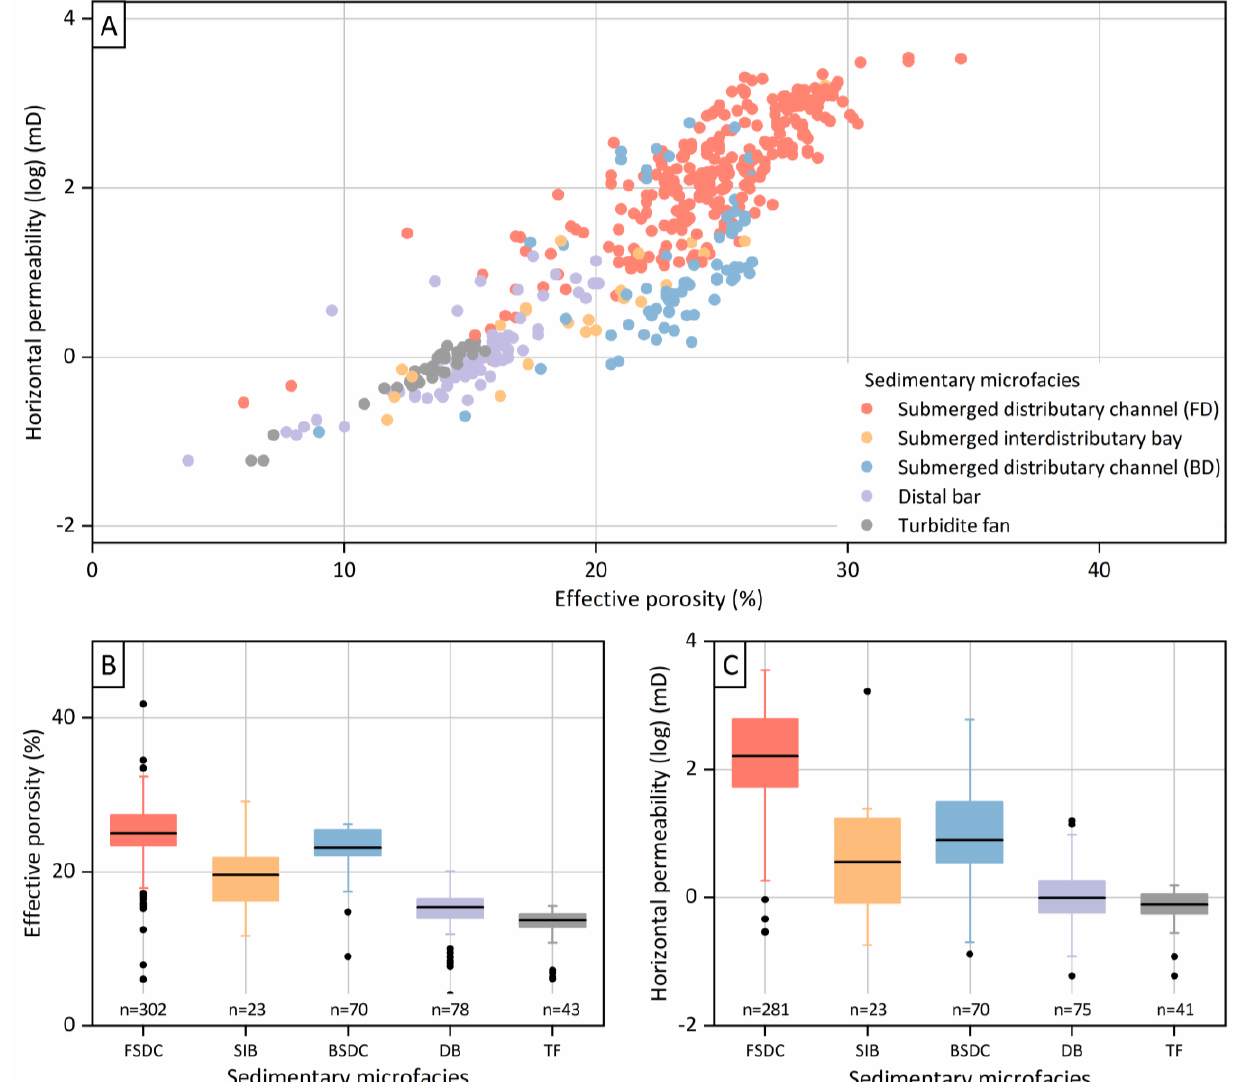
Figure 8. Porosity and permeability of sandstones in the No. 1 structural belt. ( A ) Scatter plot of effective porosity versus horizontal permeability split by sedimentary microfacies; ( B ) Boxplot of core effective porosity data of each sedimentary microfacies; ( C ) Boxplot of core horizontal permeability data of each sedimentary microfacies, where “n” is the number of samples. Each box displays data between the upper and lower quartile, and the black line represents the median. The highest and lowest values are revealed by the whiskers. Over 1.5 times the upper or lower quartile are considered outliers marked by black dots.